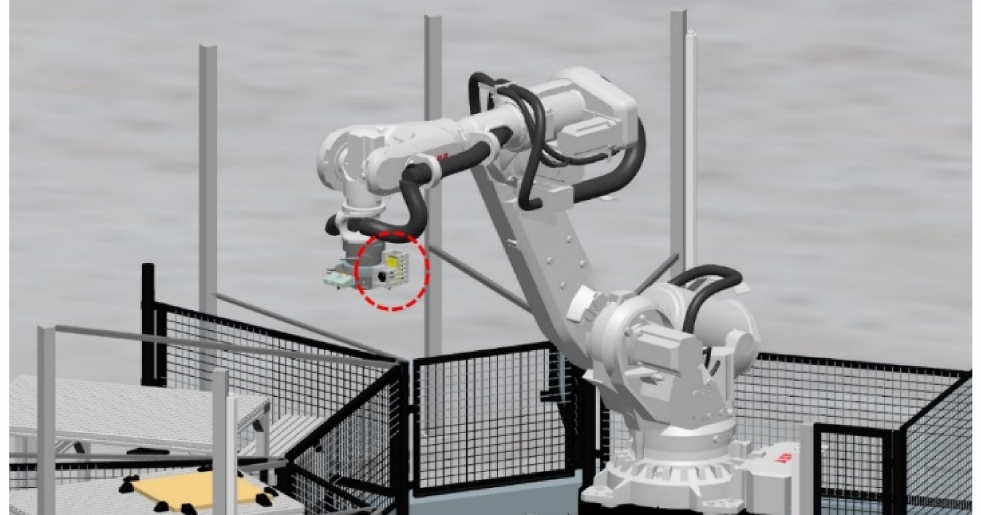
Figure 9. Shows where the protective housing, for the Cognex D900 camera is fixed on the IRB 6700:s tool changer. The protective housing is seen inside the dashed circle. The figure is a snapshot from a simulation in